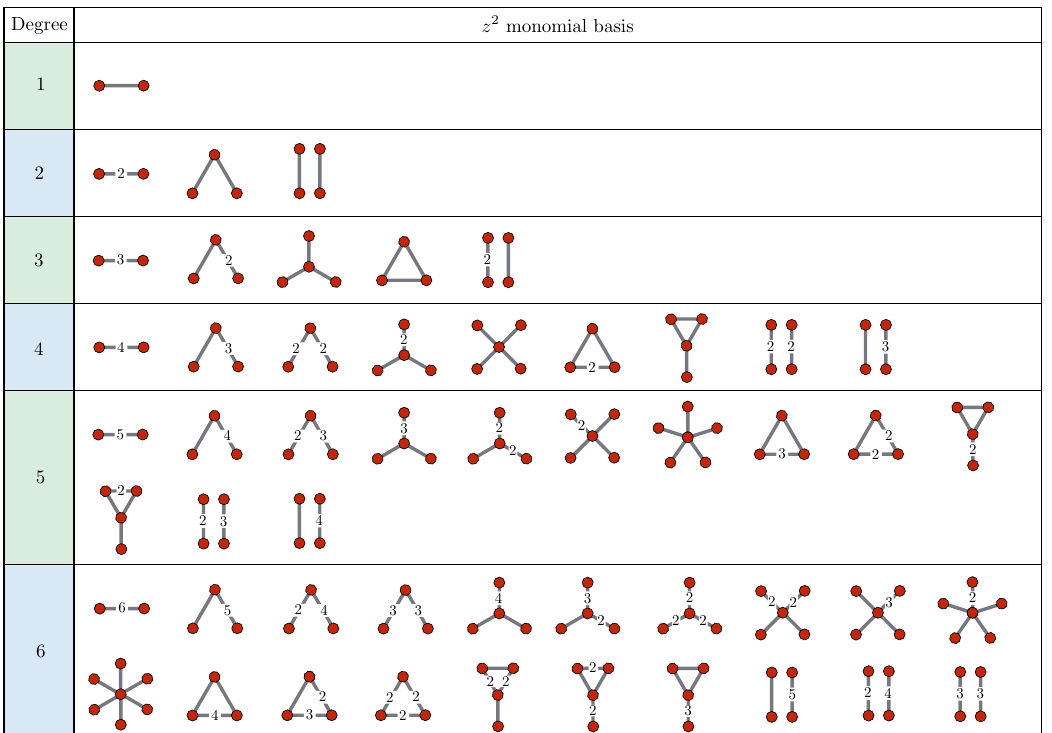
Table 8. The z 2 -truncated basis of EFPs up to degree 6. A generic EFP up to degree 6 can be expressed as a linear combination in terms of these bases